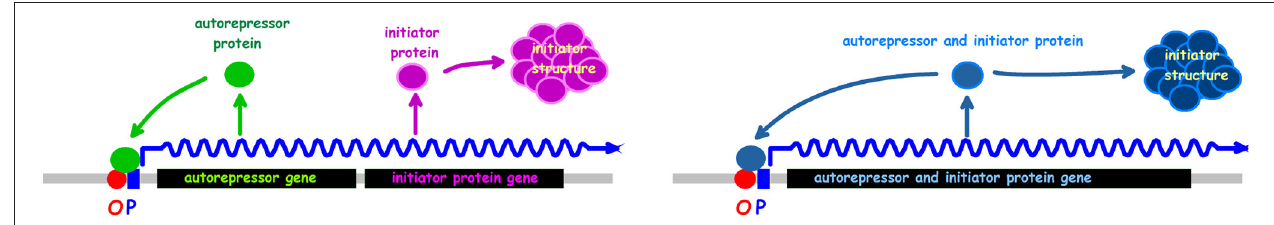
FIGURE 9 | The autorepressor model. The left drawing presents the model in its original formulation (Sompayrac and Maaløe, 1973). The right drawing shows an alternative where the autorepressor and initiator is the same protein.